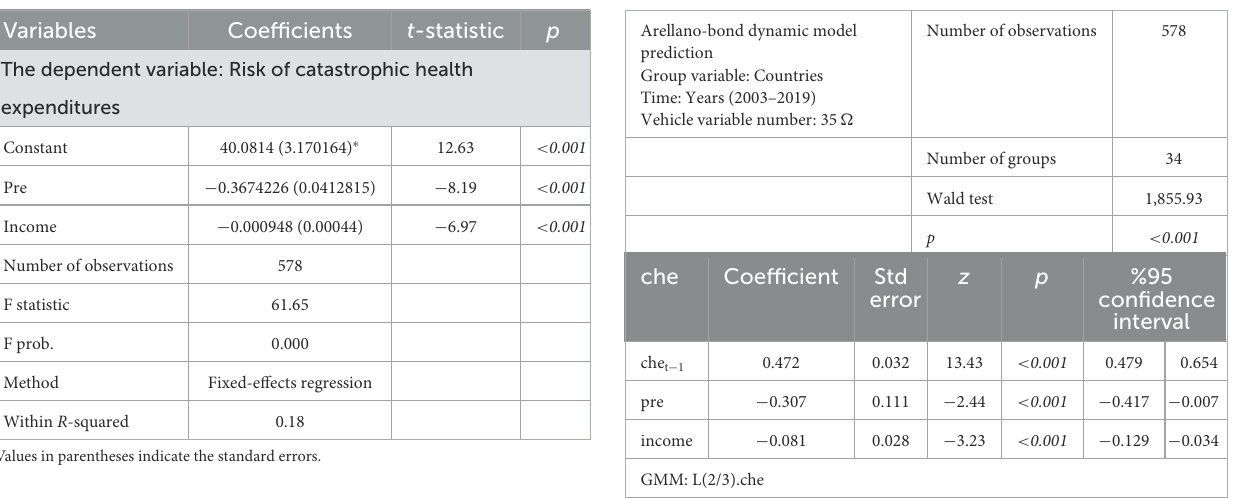
TABLE 3 Panel data analysis fixed effect model estimate results. TABLE 4 Arellano-bond robust standard errors GMM estimator